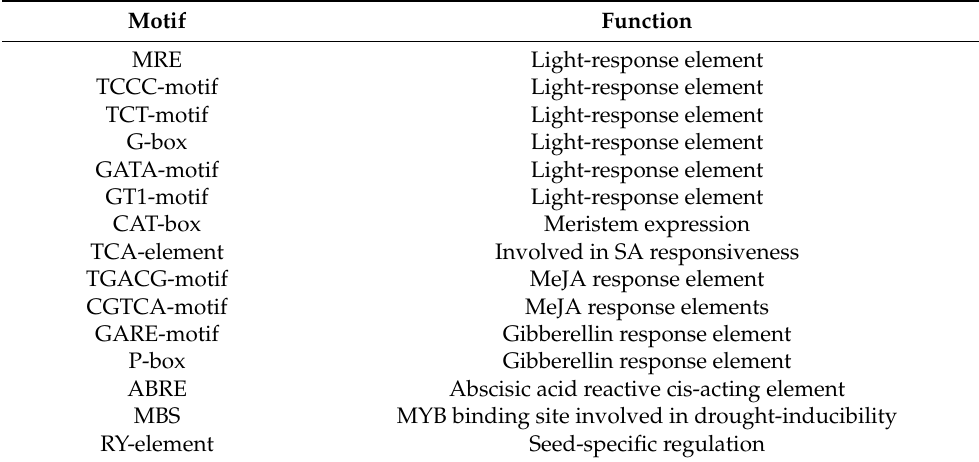
Figure 2. The protein sequence alignment of MaTGA8 and the TGAs family of Aarabidopsis and Oryza sativa . The sequences marked with thick black line are the conserved bZIP domain and the DGO1 domain. The sequences with a black background indicate completely identical residues, and the sequences with a gray background indicate similar residues. Table 1. Prediction of the cis-acting elements of the MaTGA8